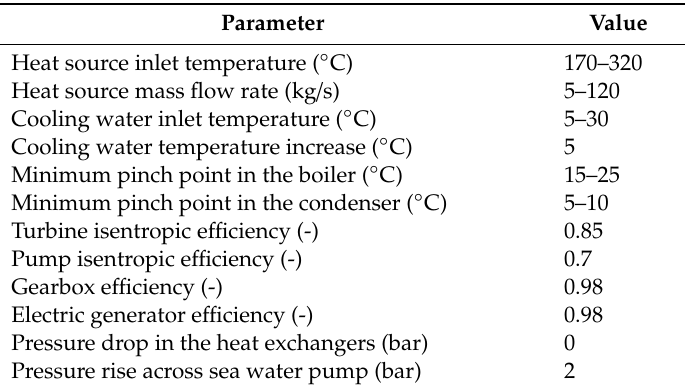
Table 2. ORC design model: fixed